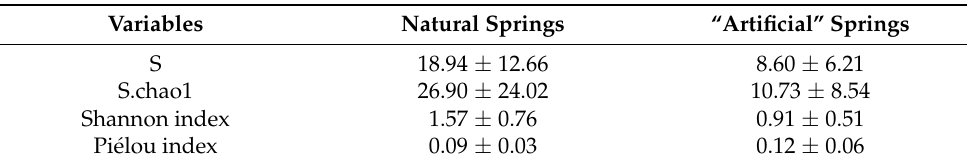
Table 3. Mean of the different diversity characteristics (mean ± SD) of the natural versus “artificial” springs.